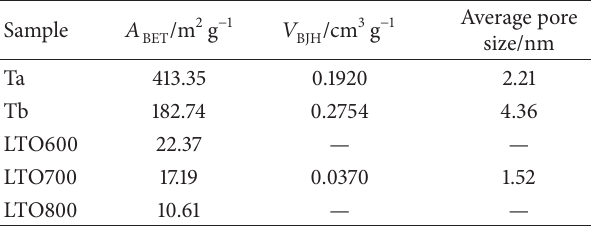
Figure 4: TEM images (a, b), HRTEM images (c), and the EDX spectrum (d) of sample LTO700. method. Only Ti and O elements are detected in the energy Table 1: Textural properties of samples Ta, Tb, and